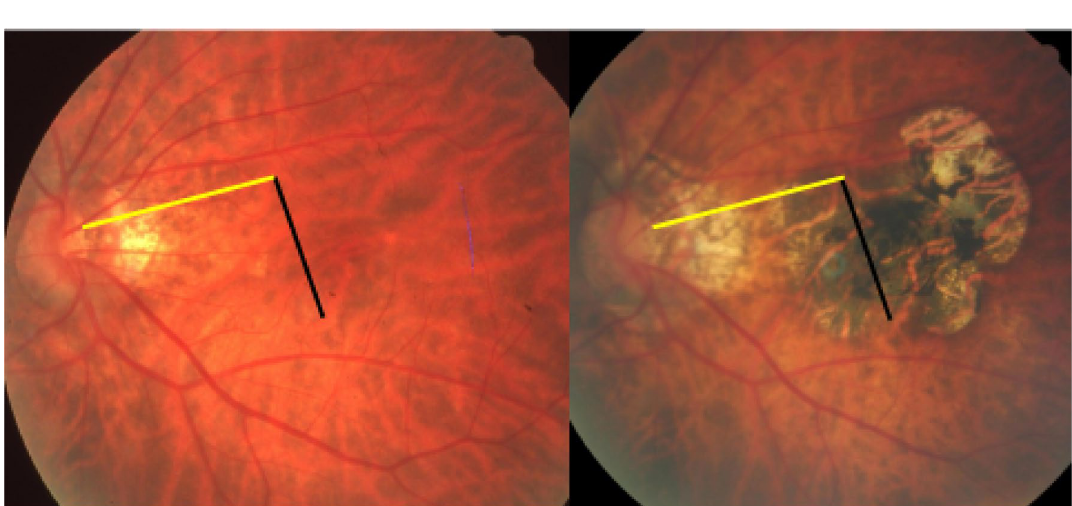
Figure 7. Fundus photographs of a highly myopic eye taken with an interval of 10 years. Note : development of a foveal Bruch’s membrane defect (as category 4 of myopic macular degeneration) with an apparent intact large choroidal vessel layer. No change in the distance between two choroidal vascular markings, compared between baseline (black bar) and follow up (equally long vertical black bar), and no change in the distance between the choroidal marking and the disc border (equally long yellow